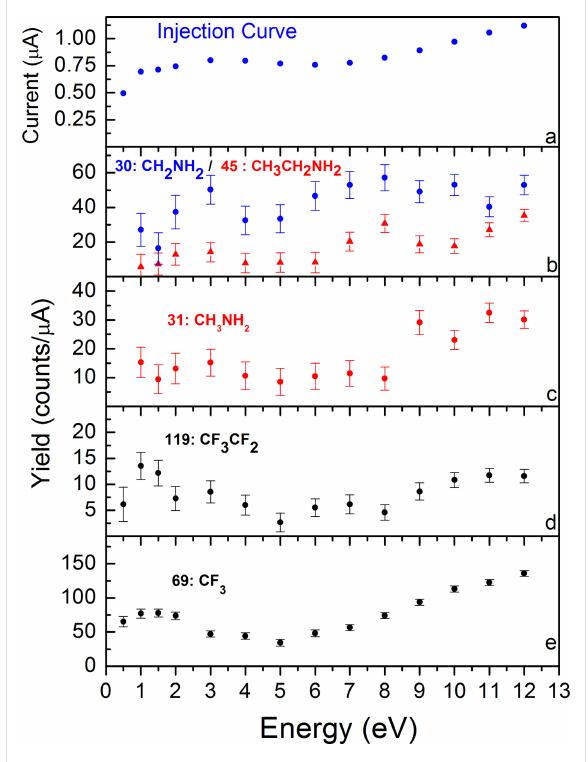
Figure 3: ESD experiments on compound A deposited on a Si wafer. (a) Mean current measured during irradiation; (b–e) recorded signal for neutral species detection, respectively, mass 30 (blue) and 45 (red), mass 31 (red), mass 119 (black), mass 69 (black). Most probable attri- butions are given in the corresponding